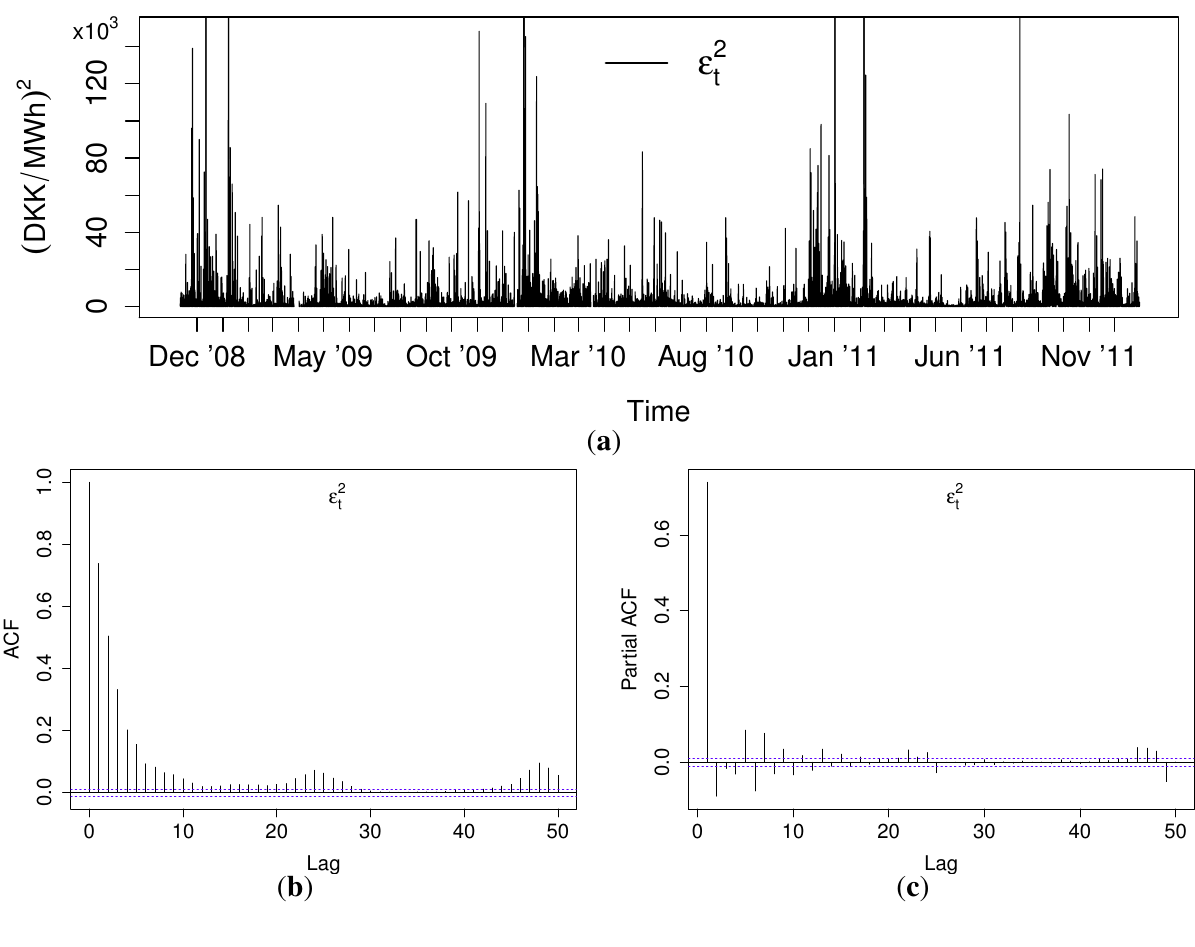
Figure 5. Time series plot of ε 2 ( a ), as well as ( b ) the series autocorrelation function (ACF), t and ( c ) partial autocorrelation function